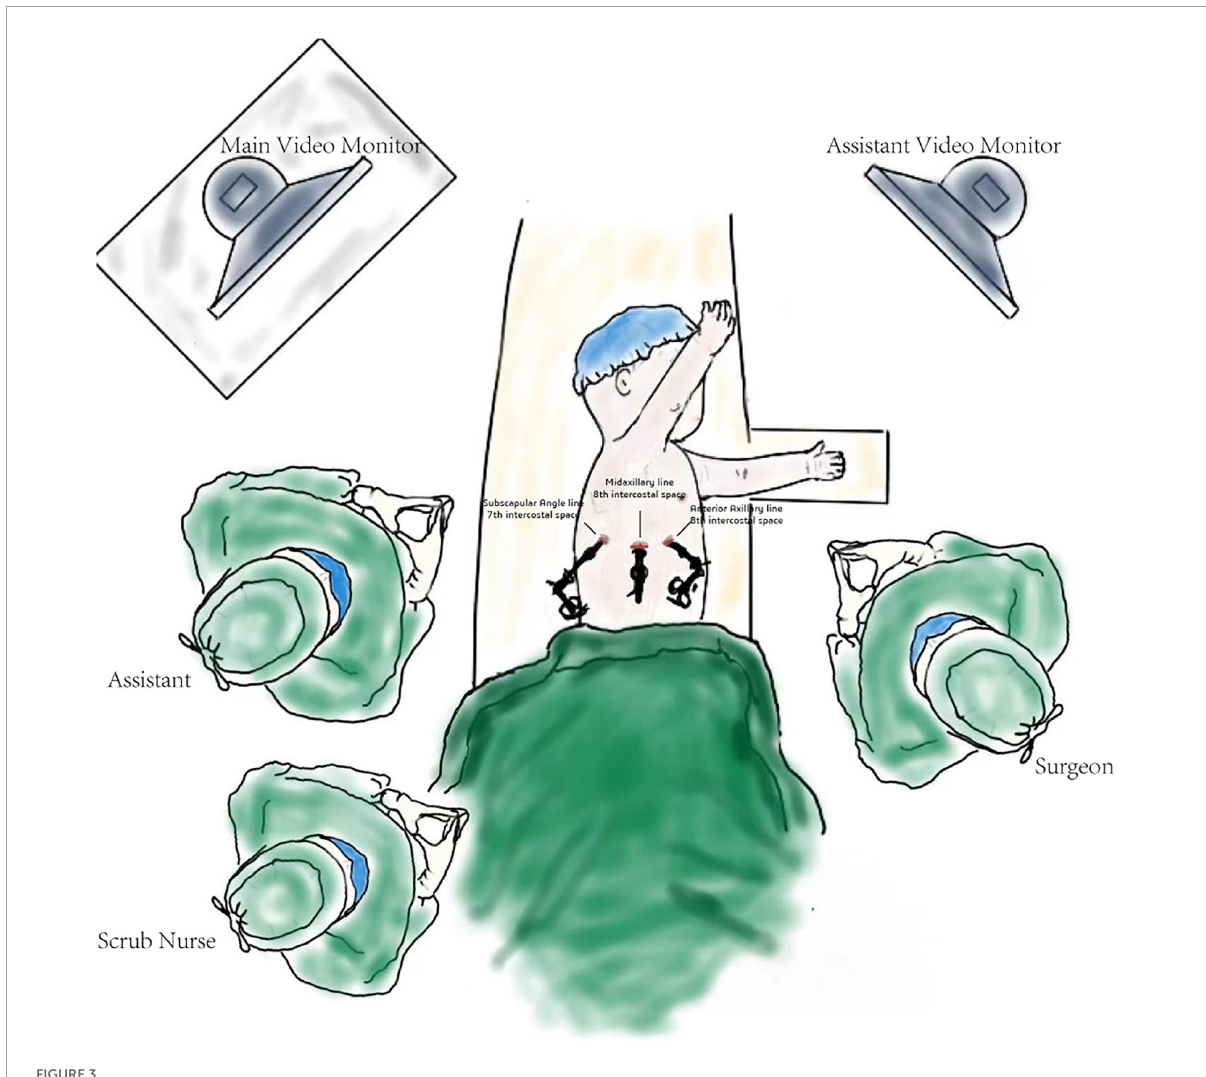
FIGURE3 Schematic diagram of the